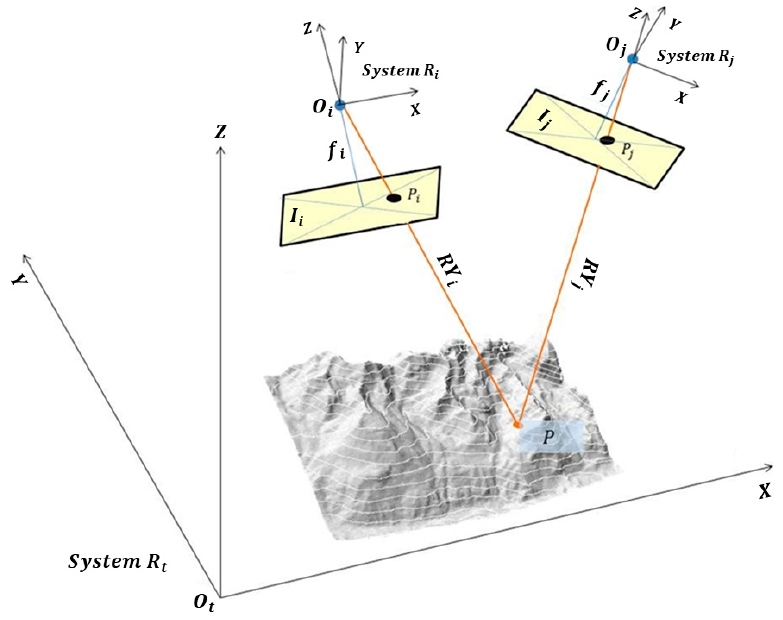
Figure 4. Spatial reference systems in the two frames.